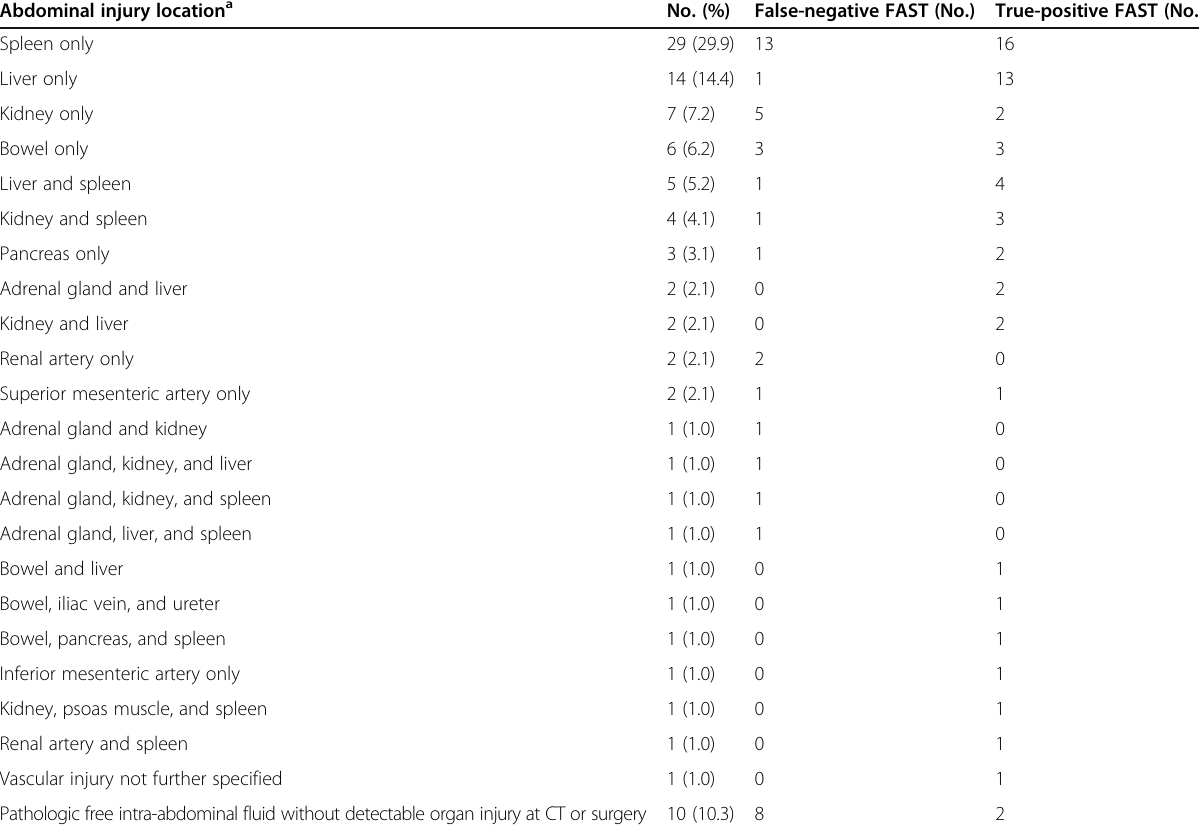
Table 2 Summary of abdominal injuries and FAST results in the 97 included patients Abdominal injury location a